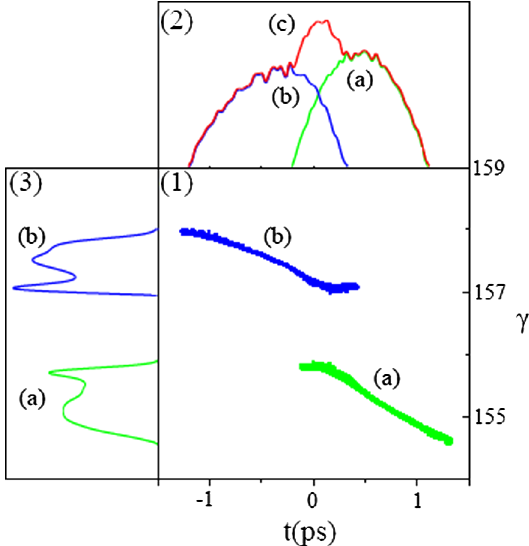
FIG. 1. Beam A — Simulation by T STEP . (1) Phase space. (a) Low energy and (b) high energy beamlets. (2) Total (c) and partial [(a) and (b)] electron current. (3) Energy distribution.